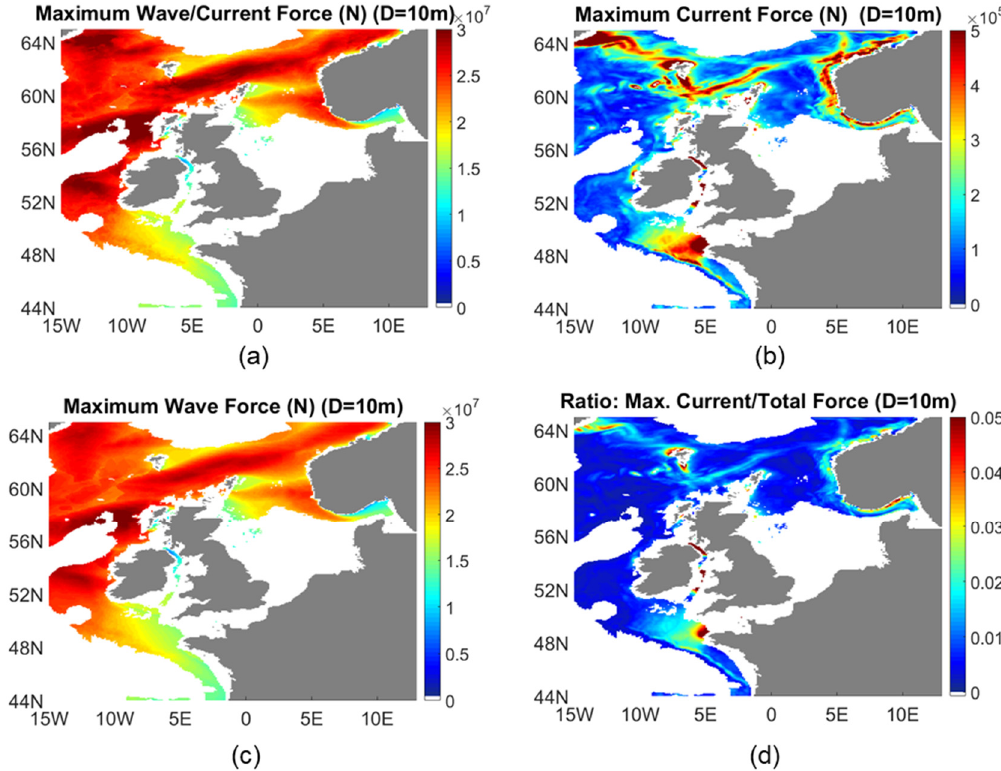
Figure 7. Spatial maps of maximum wave/current force ( a ), current force ( b ), maximum wave force ( c ) and ratio of current force contribution to total force ( d ), on a pile of diameter D = 10 m, of 100 m height and deployment depth from 100 m to 2000 m, from Met Office FOAM and WaveWatch III model outputs on the AMM7 grid over period July 2014 to June 2016.